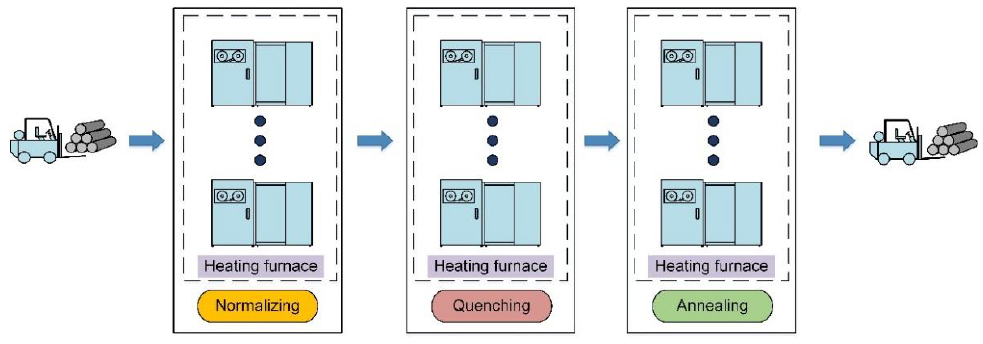
Figure 6. Heat treatment process flow.